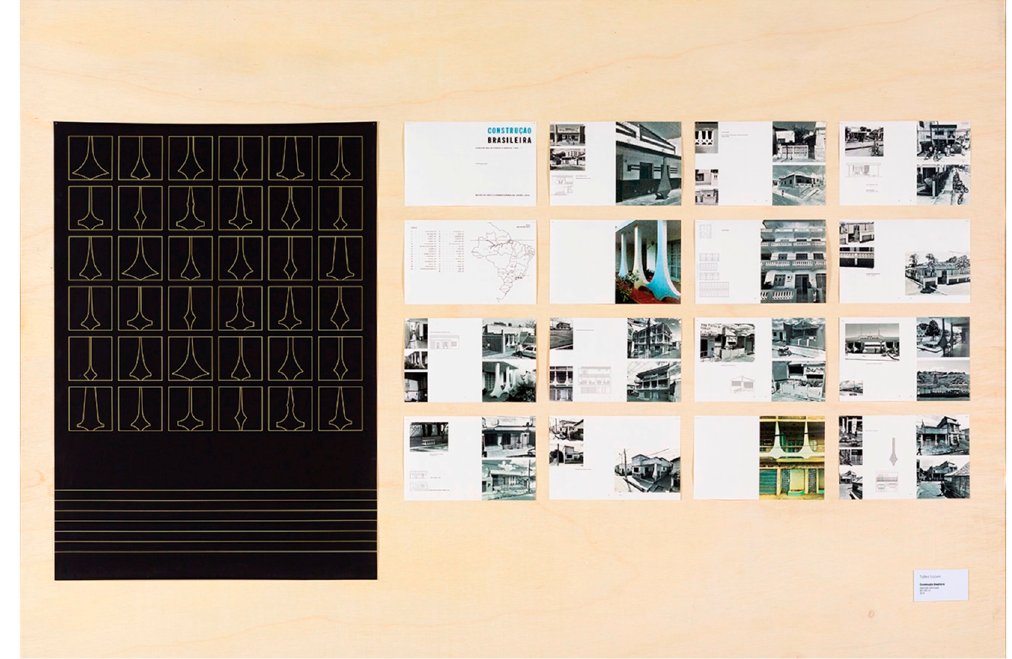
Figure 3. Talles Lopes, Brazil Builds: Architecture Modern and Old, 1958- , 2018, installation, courtesy of the artist.